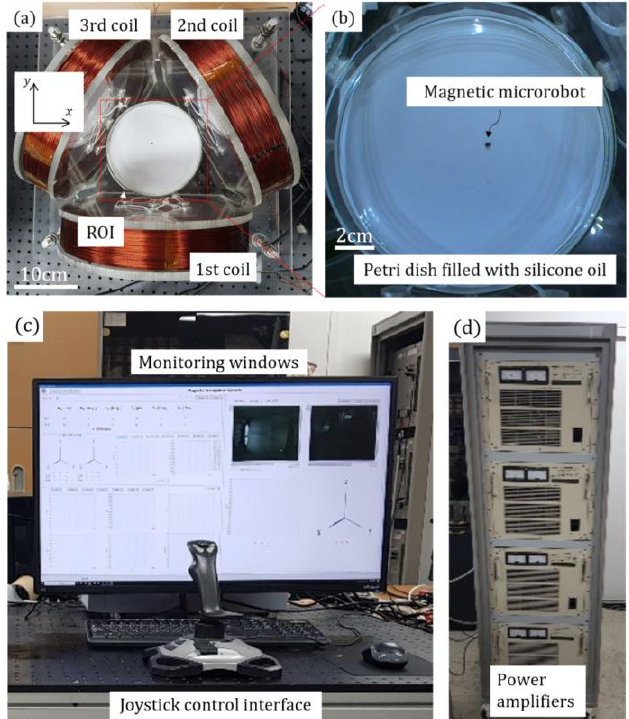
Figure 2. Experimental setup of the ( a ) TEC, ( b ) magnetic microrobot, ( c ) control panel, and ( d ) power amplifiers to demonstrate the 2D microrobot motions using the TEC.